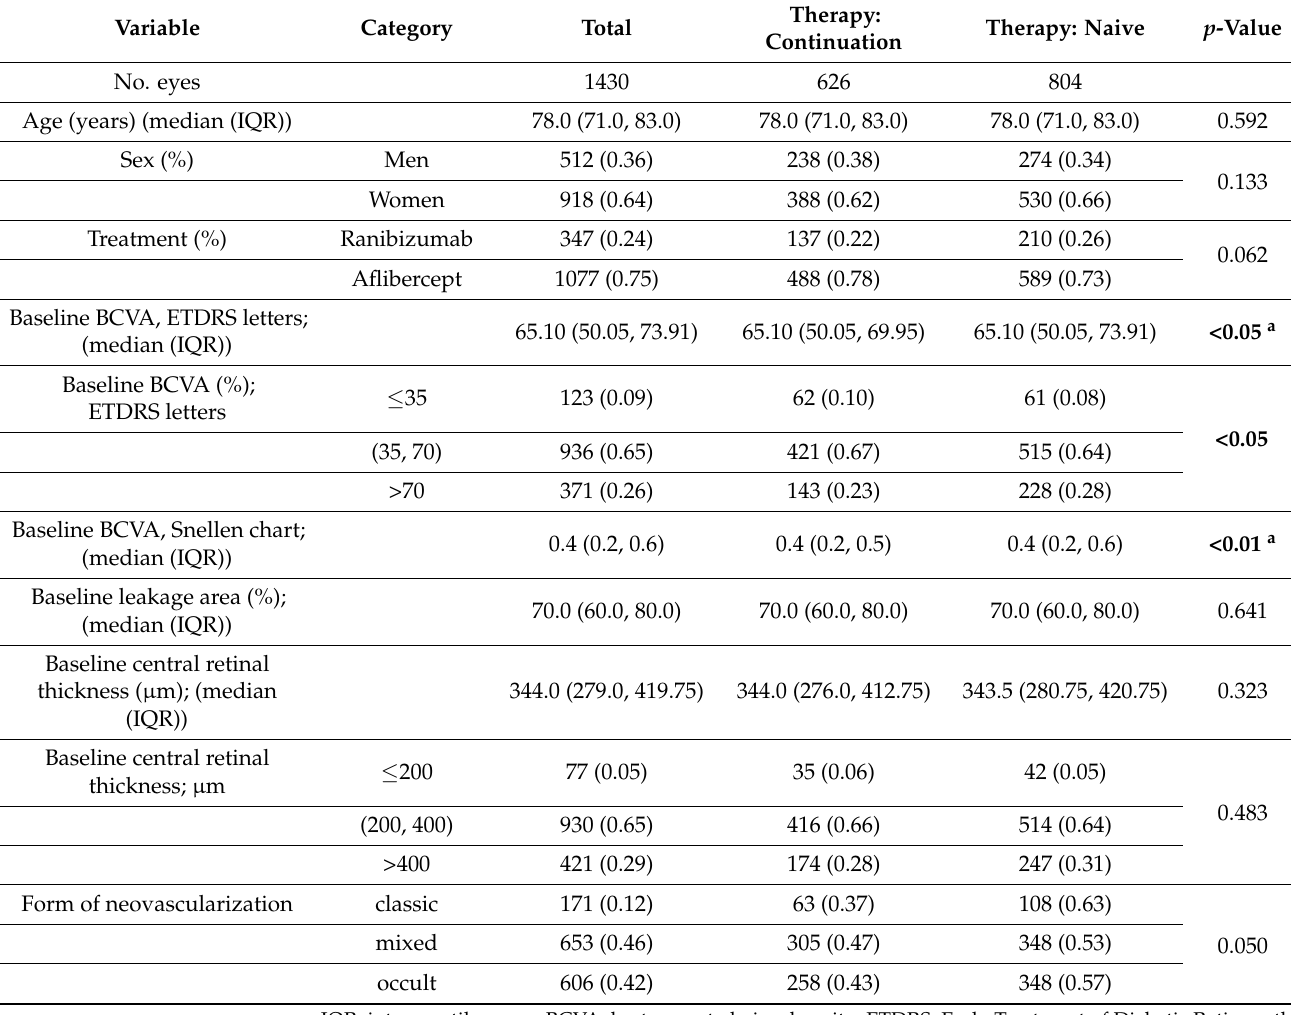
Table 1. Patients’ baseline